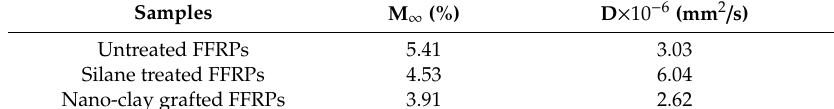
Table 2. Maximum water uptake and diffusion coefficient (D) of FFRPs at 70 °C under 80% RH.